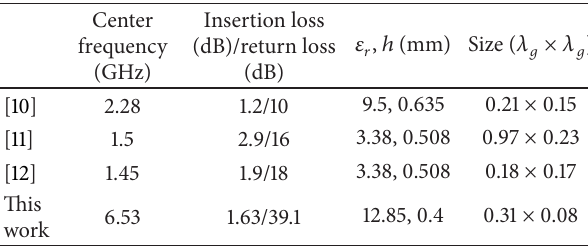
Table 1: Comparison with other reported